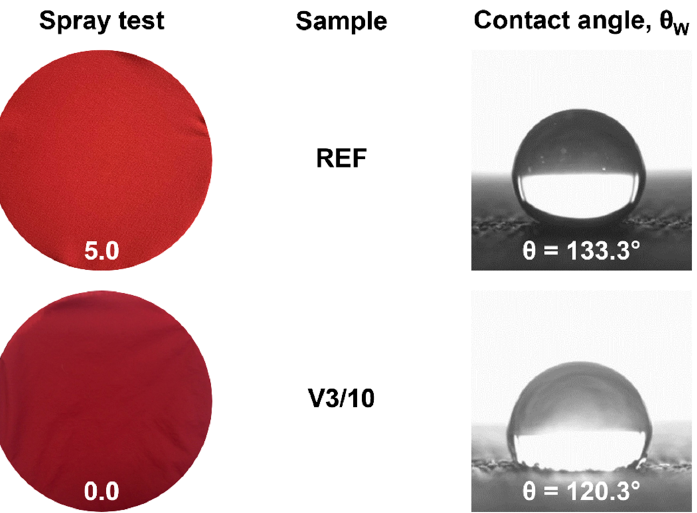
Figure 6. The sample results of spray test and contact angle measurements ( θ W ) for PA/PES fabric. The explanation for these differences in interpretation is that the spray test and goni- ometric methods provide different information, due to the different nature of the tests.